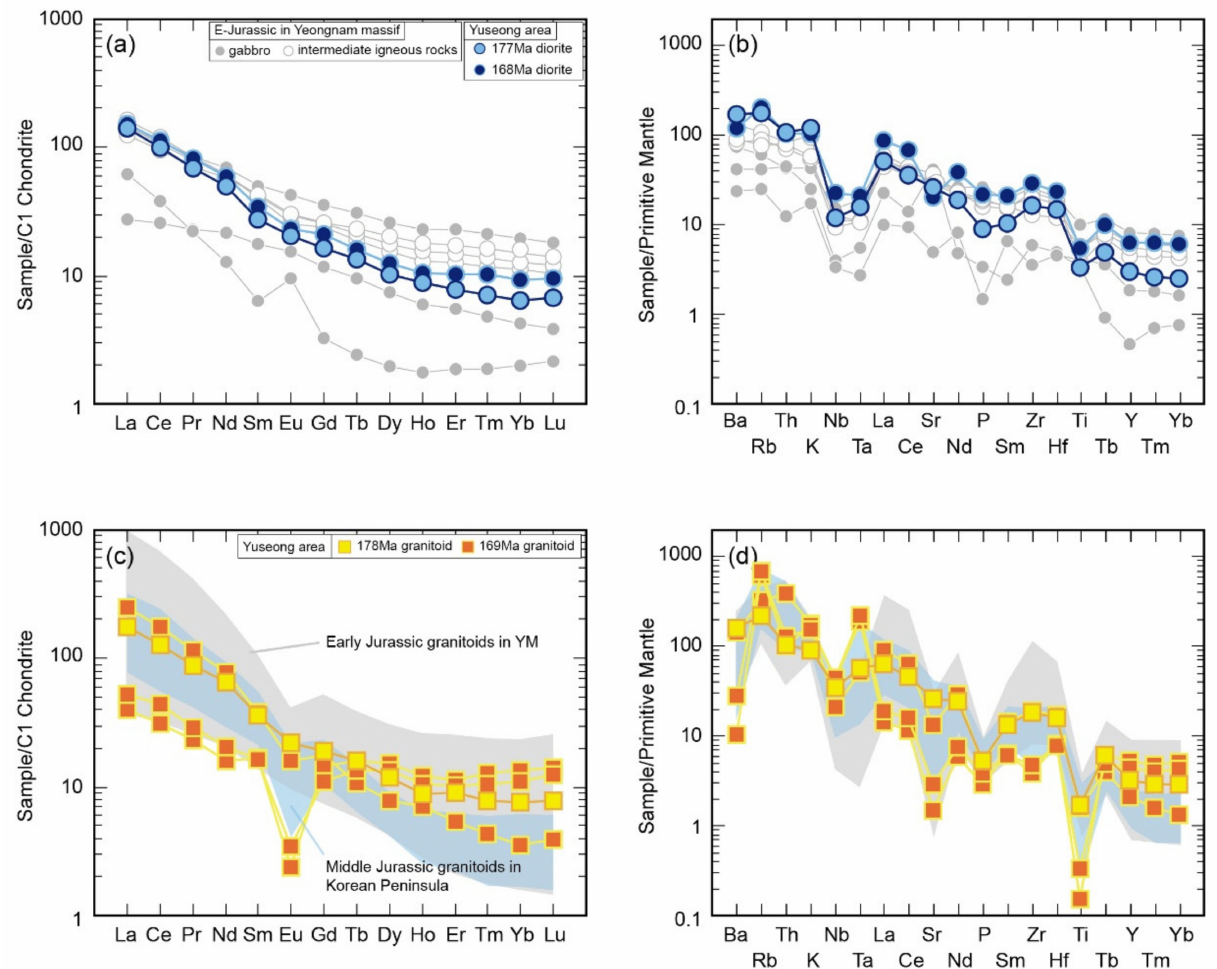
Figure 6. Chondrite-normalized REE and primitive mantle-normalized multi-element patterns for the Early Jurassic gabbro and intermediate igneous rocks in the YM and Jurassic diorite in the Yuseong area ( a , b ) and for the Early Jurassic granitoids in the YM, Jurassic granitoids in the Yuseong area and Middle Jurassic granitoids in the Korean Peninsula ( c , d ). Chondrite- and primitive mantle-normalized values are from McDonough and Sun